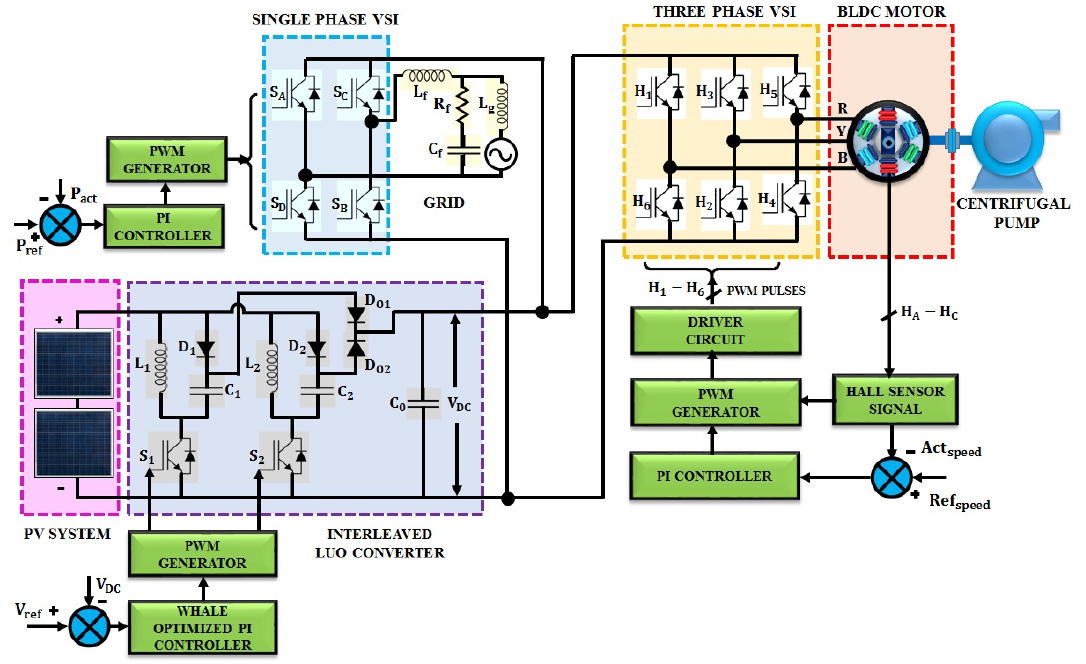
Figure 1. Circuit of the proposed grid-interactive solar photovoltaic powered brushless direct current motor-driven water pumping system.